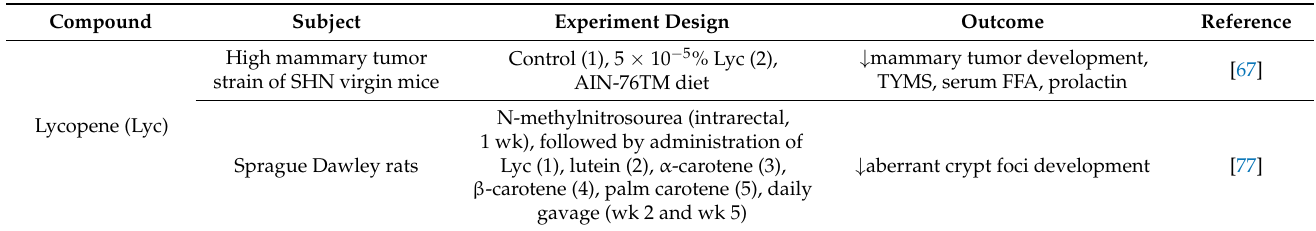
Table 2. Summary of animal studies evaluating anti-cancer properties of